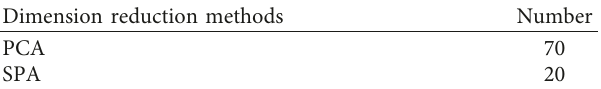
Table 5: The optimal values of cost and gamma parameters of SVM models.